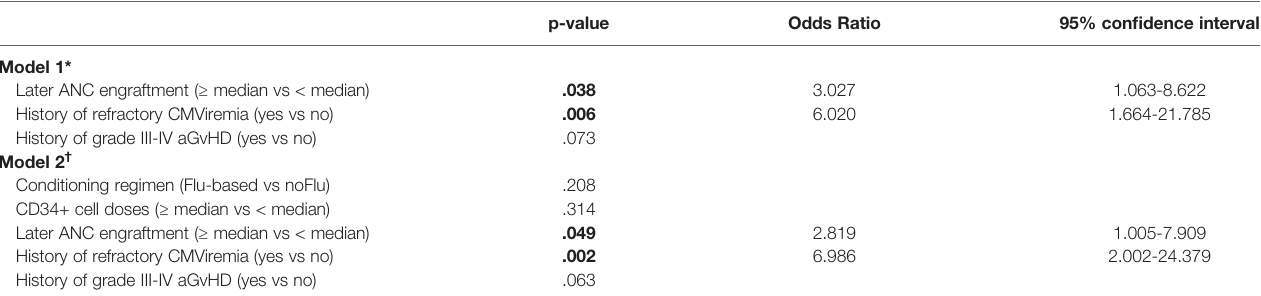
TABLE 2 | Multivariable analysis of factors associated with